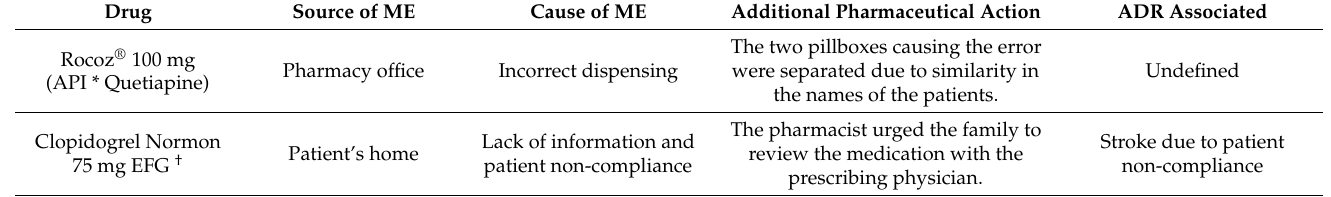
Table 5. Characteristics of the serious ME cases reported (Catalonia,